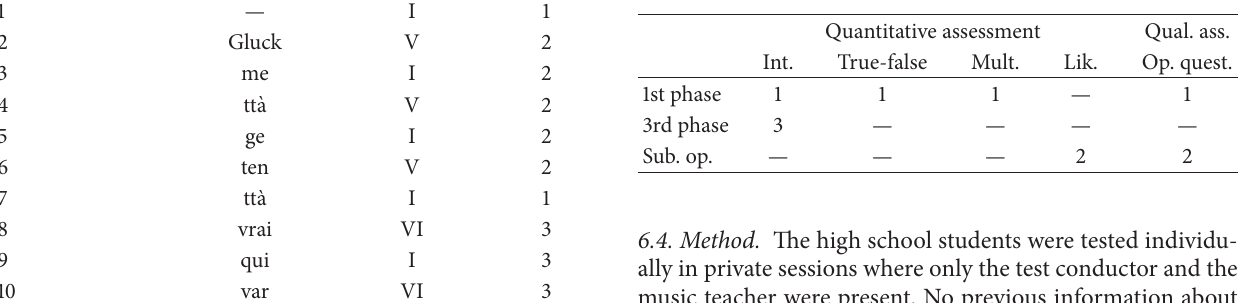
Table 2: Table of musical segments, syllables of change, chords and harmonic rhythm of Adriano Celentano’s Il ragazzo della via Gluck . Number of Seg.